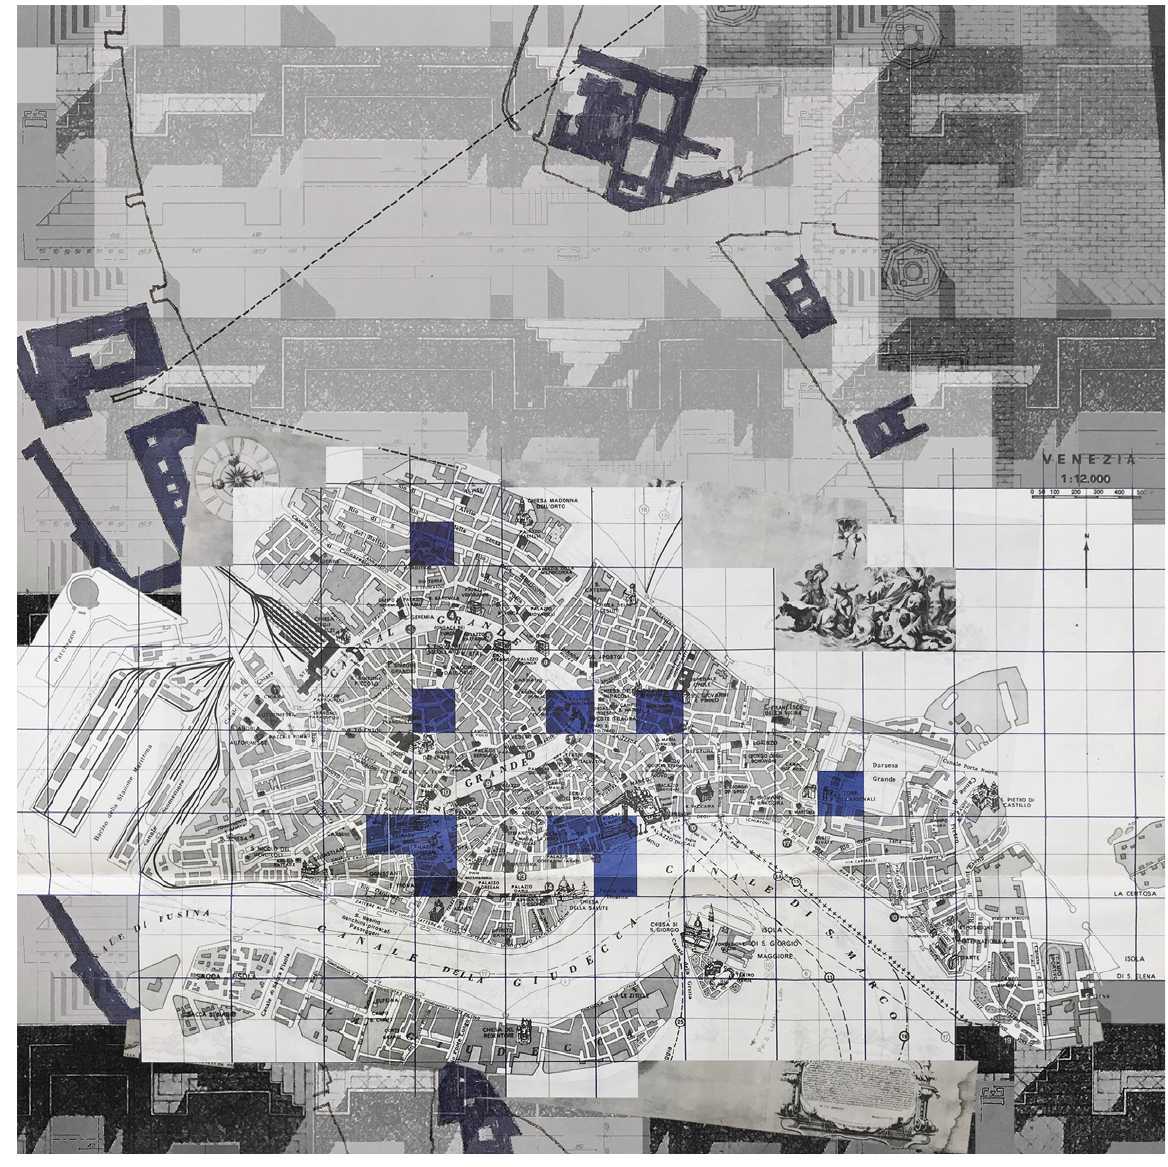
FIG. 4 Montage edited by the author including: an historic map of Venice (Ludovico Ughi, 1729) superimposed on the 200 square-meter grid; map of contemporary Venice (1979) showing the blue squares for which the ephemeral architecture project is